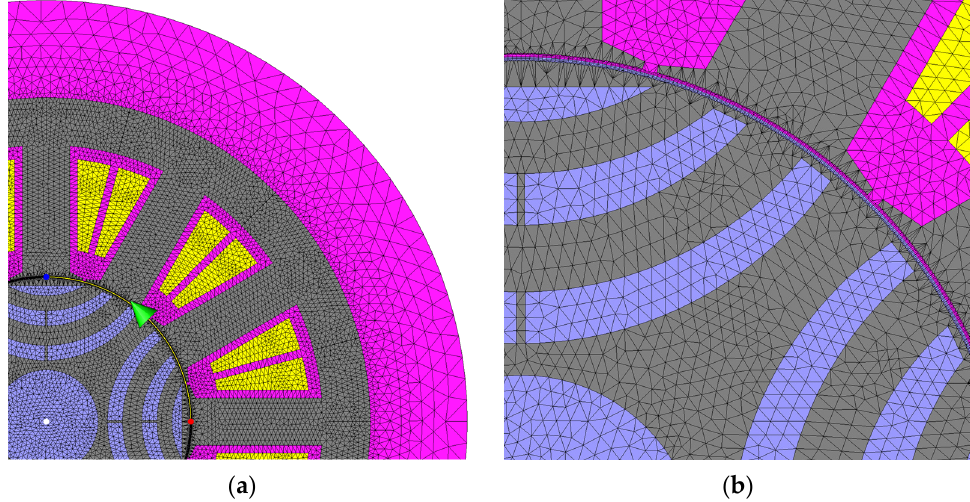
Figure 5. Elements in the FEA mesh. ( a ) The path to plot air-gap flux density, ( b ) mesh details.